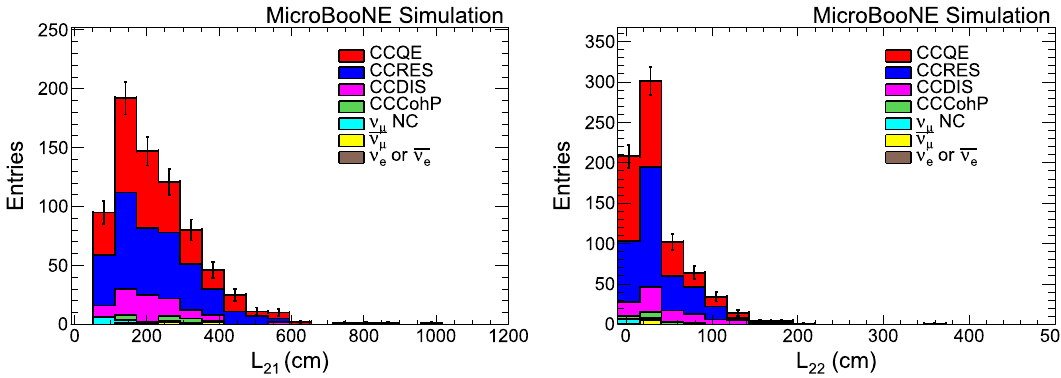
Fig. 30 Multiplicity = 2 track length distribution for candidate muon (left); for second track (right) from GENIE default MC. Black error bars represent MC statistical